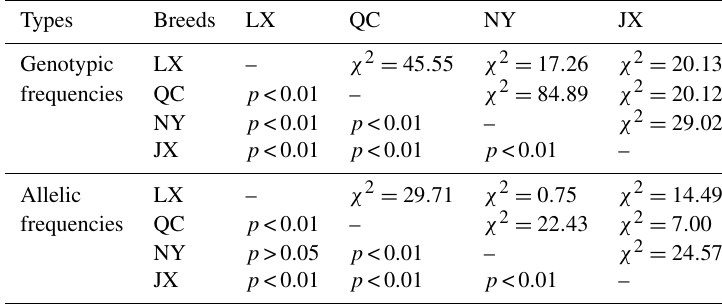
Table 3. The χ 2 test of different breeds on a novel indel of the cattle AR gene. Types